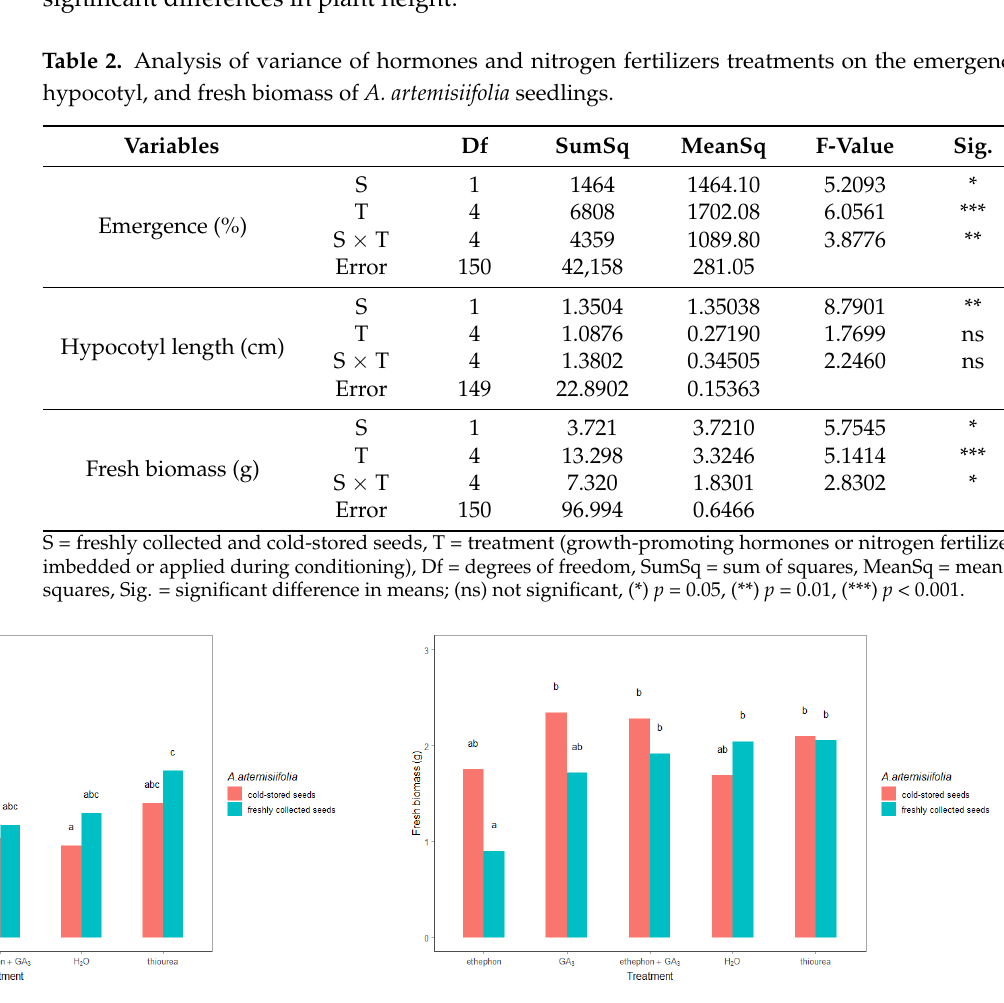
Figure 6. Initial growth parameters of young Ambrosia artemisiifolia plants that were grown from freshly collected or cold-stored seeds under various chemical treatments or conditioning in the greenhouse. The estimated marginal means of 16 replicates are shown for the freshly collected seeds (standard error = 4.19) and cold-stored seeds (standard error = 0.201). According to Tukey’s test, means following the same letter are not significantly different ( p < 0.05).